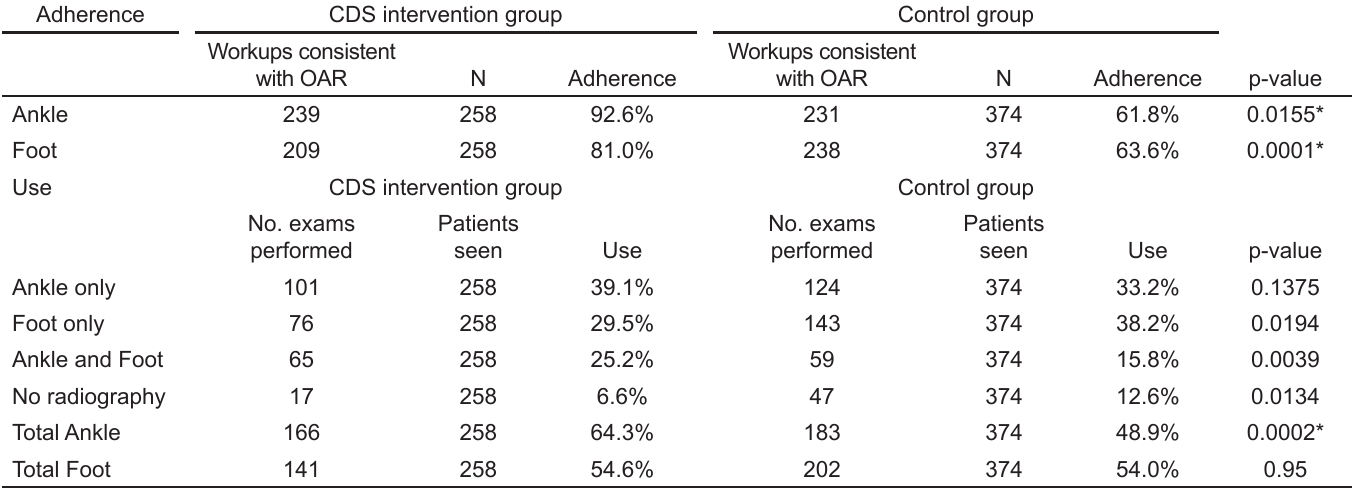
Table 2. Adherence to Ottawa Ankle Rules (OAR) and radiography use by group.